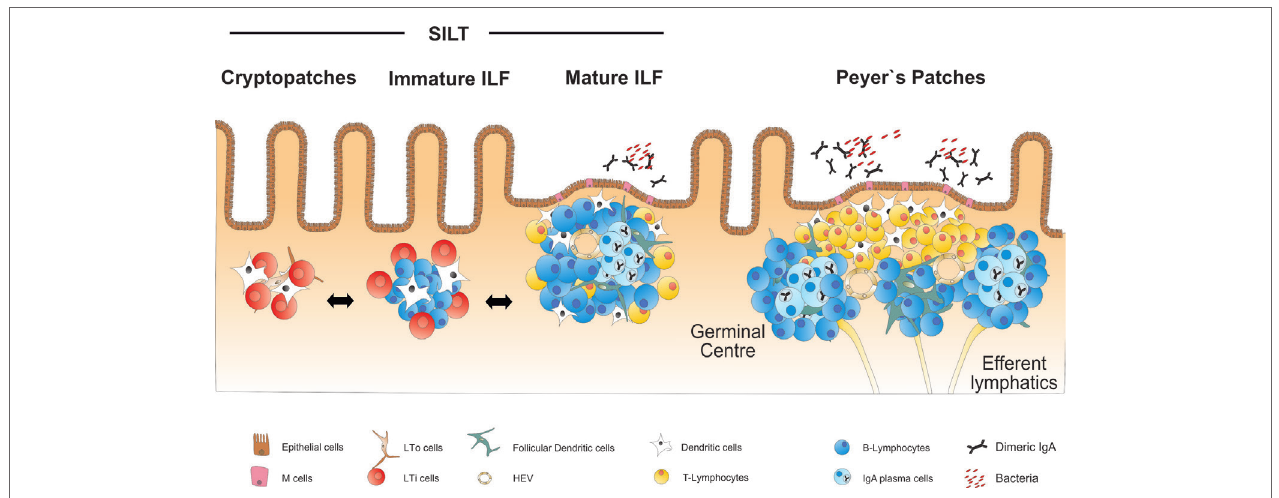
FiGURe 1 | Overview on the anatomy and structure of CP, iLF, and PP in the small intestine . SILT consists of a dynamic continuum of structures ranging from small cryptopatches (CP) to large mature isolated lymphoid follicles (ILF). CP start to develop into immature ILF by recruiting B cells. Mature ILF contain one big B cell follicle and develop germinal centers, vascular structures, and a follicle-associated epithelium. PP represent the most structured lymphoid organs in the intestine, containing several B cell follicles and distinct T and B cell